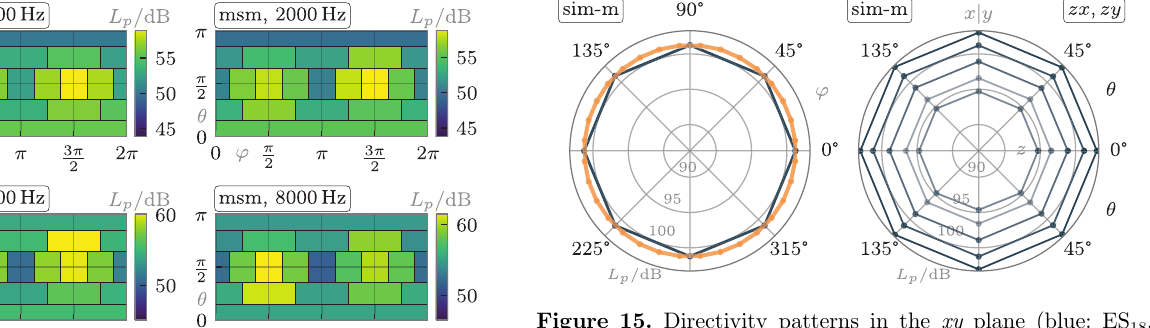
Figure 15. Directivity patterns in the xy plane (blue: ES 18 , orange: EA 512 ) for 4 kHz, and in the perpendicular planes for octave bands from 500 Hz to 8 kHz (shades from light to dark).